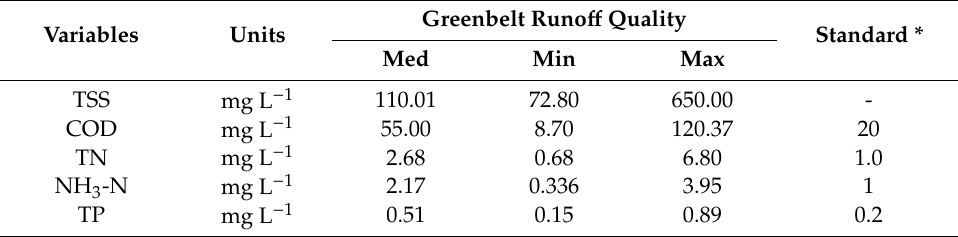
Table 8. Summary of the physicochemical characteristic of green land stormwater quality.